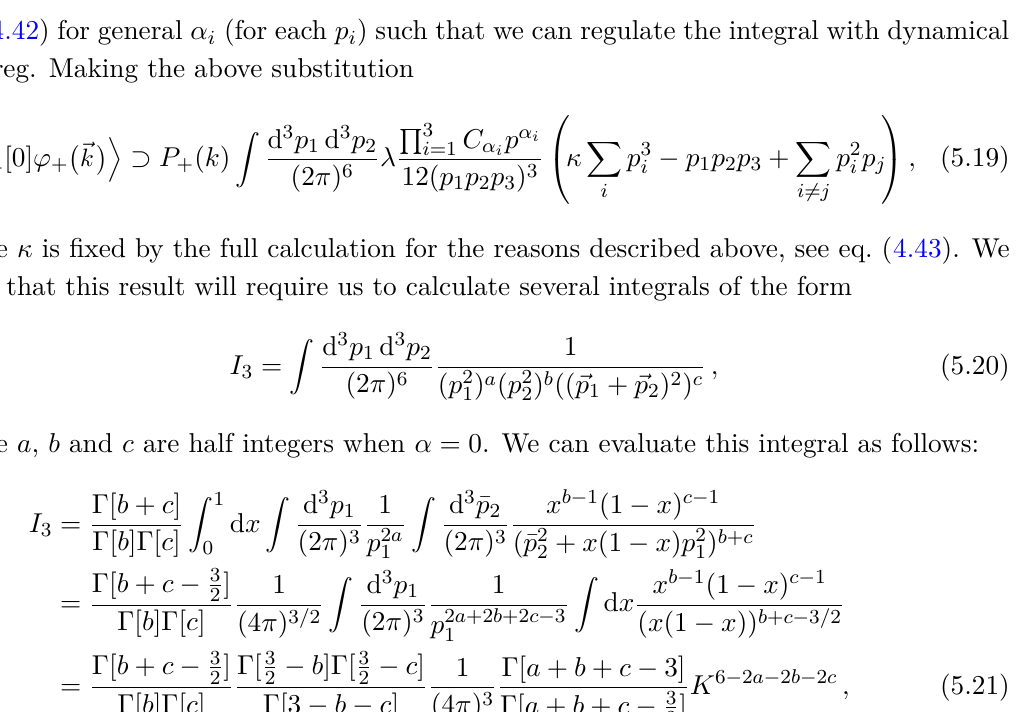
Figure 6 . Diagram of contribution two loop contribution to the mixing ϕ 3 the tree level trispectrum and integrate over three of the fields to form the composite operator ϕ 3 We first drew this as a Witten diagram with a boundary at future infinity. At the bottom we have shown the Feynman diagram with the same momentum